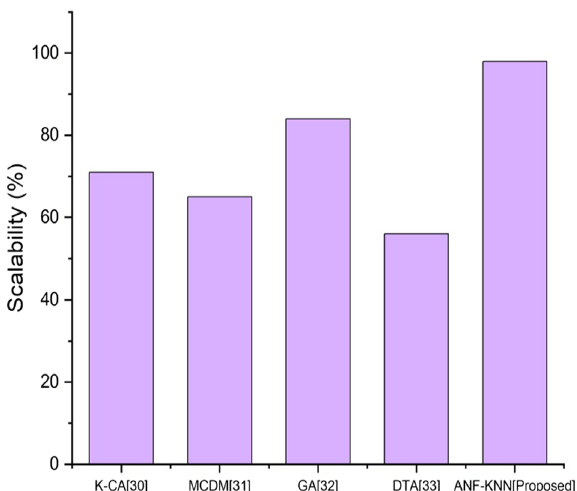
Fig. 8 Scalability comparison of existing and proposed method